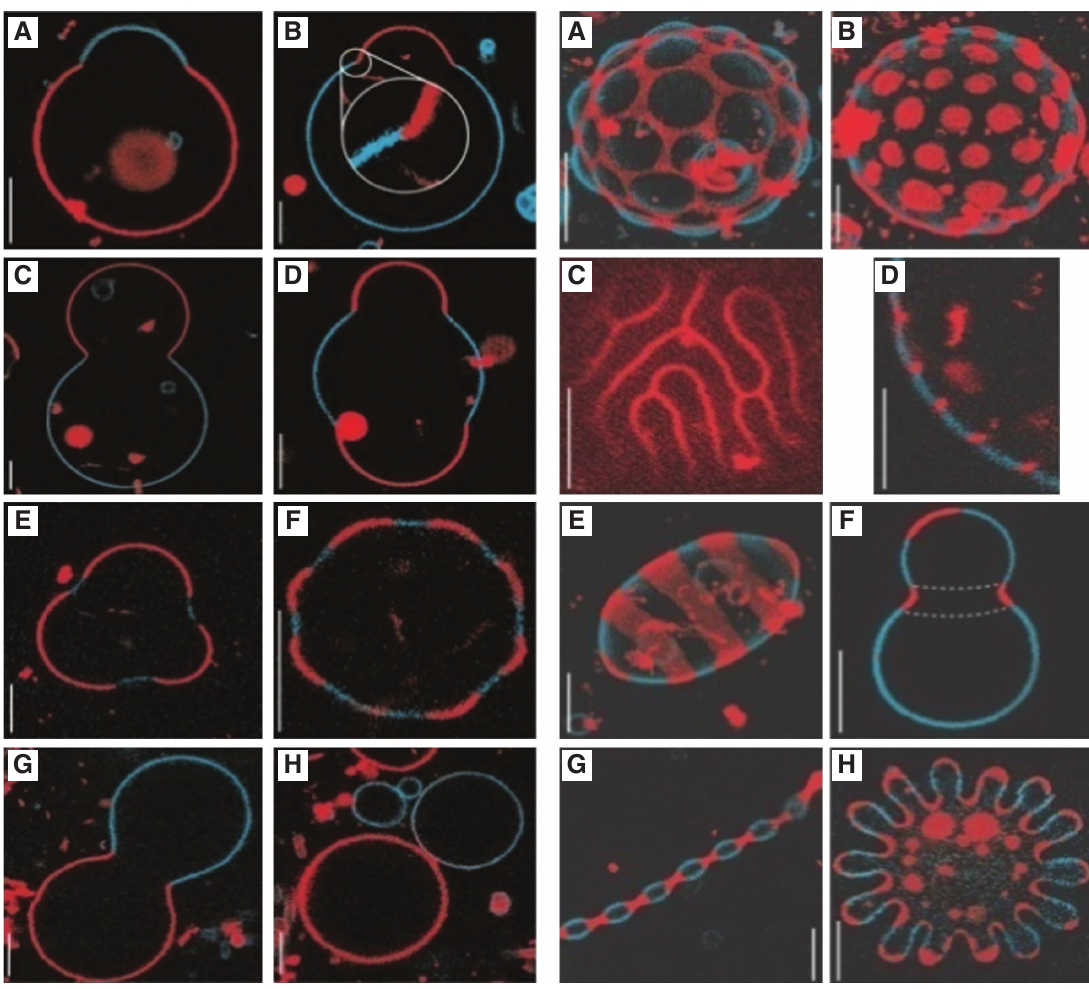
Figure 5 Phase separation and various shapes of biomembranes (cited from